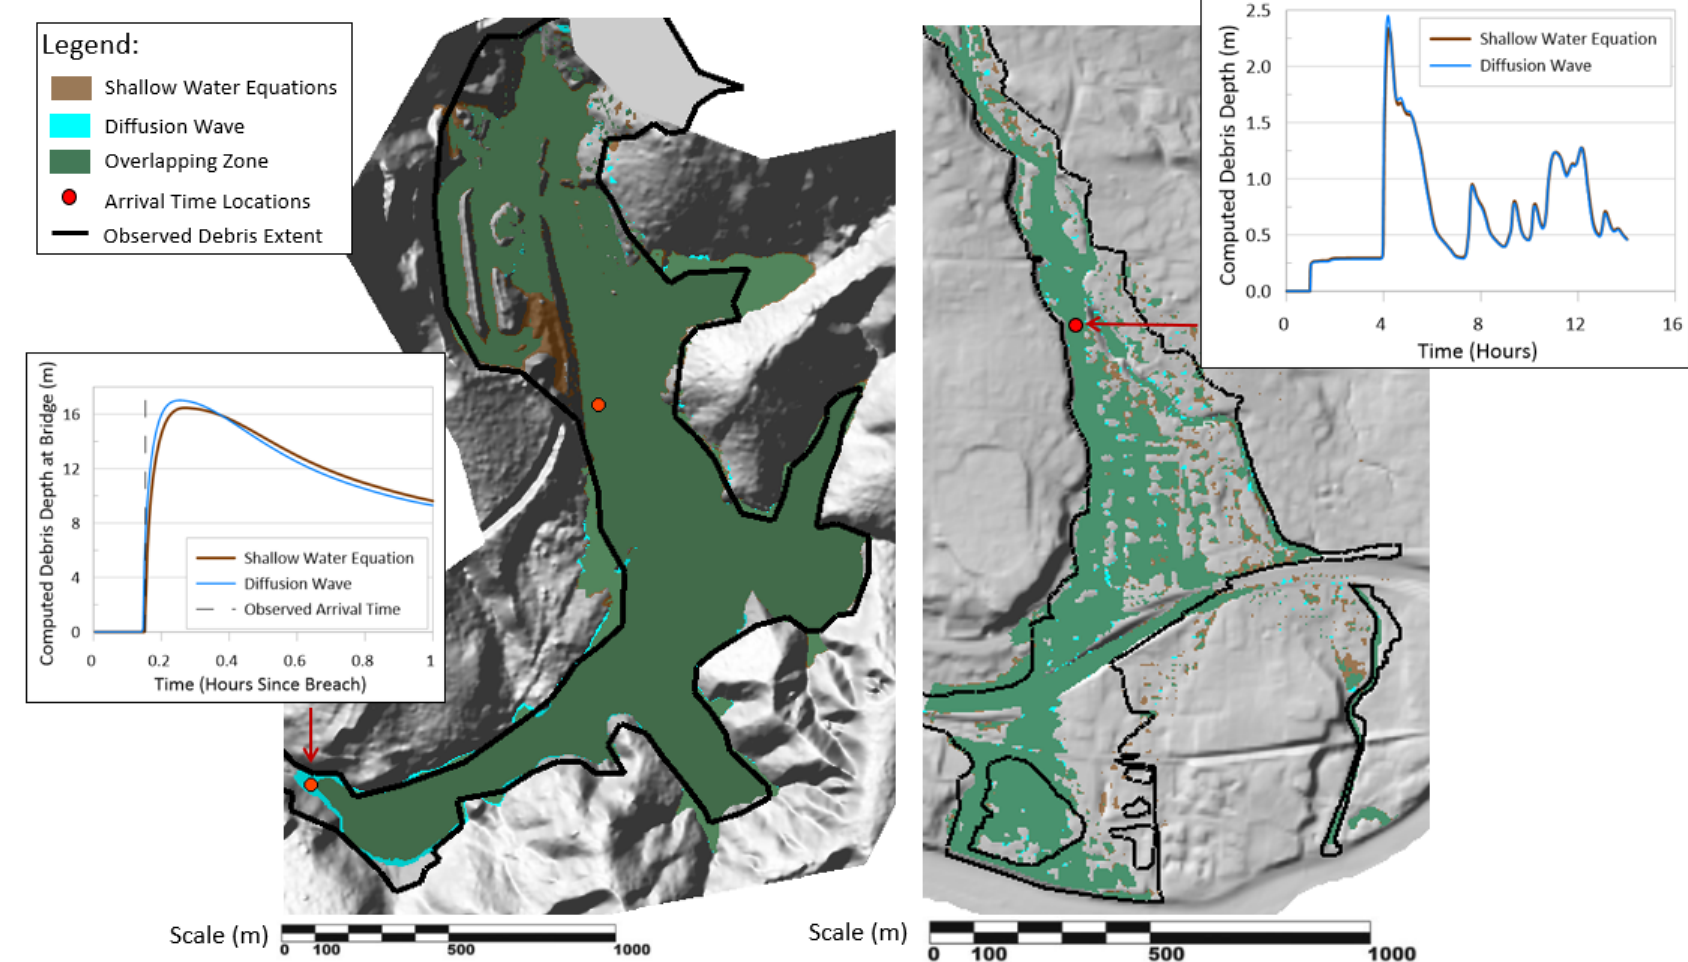
Figure 11. Brumadinho and Montecito model results with SWE and DW equations. The DW models did not differ substantially from the SWE simulations.